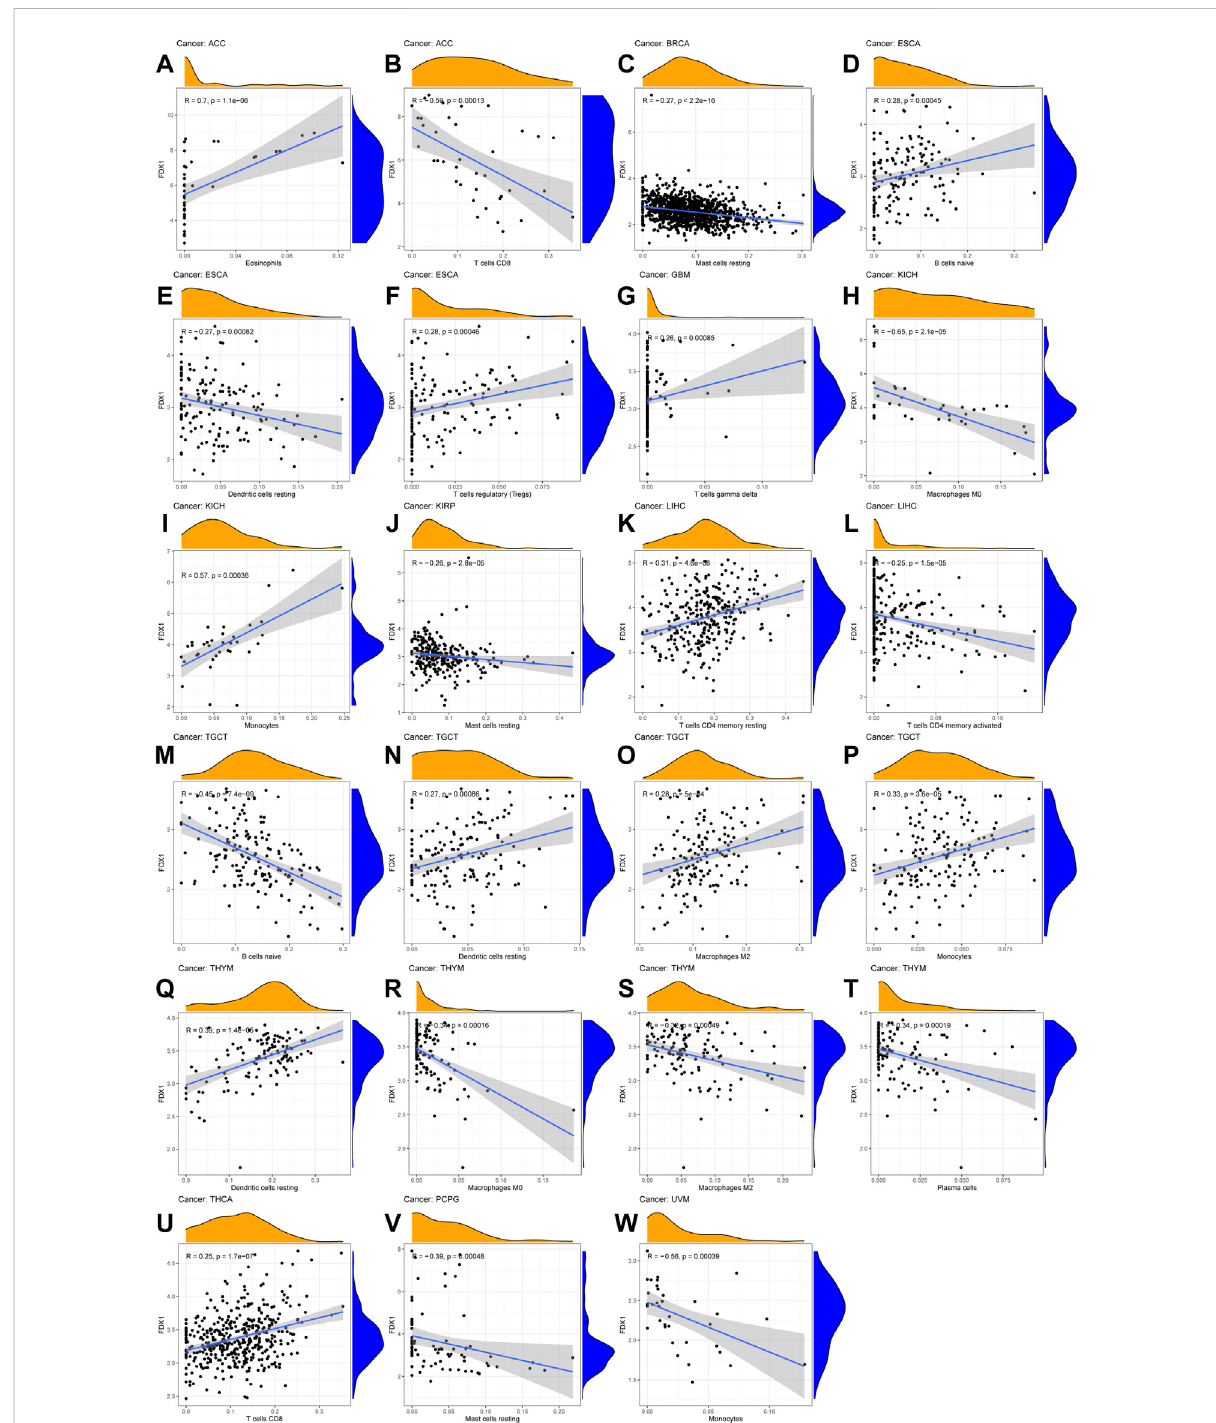
FIGURE 7 The correlation between FDX1 expression and immune cell in fi ltration (A – W) Scatter plots showing that tumor-in fi ltrating immune cells were signi fi cantly correlated with FDX1